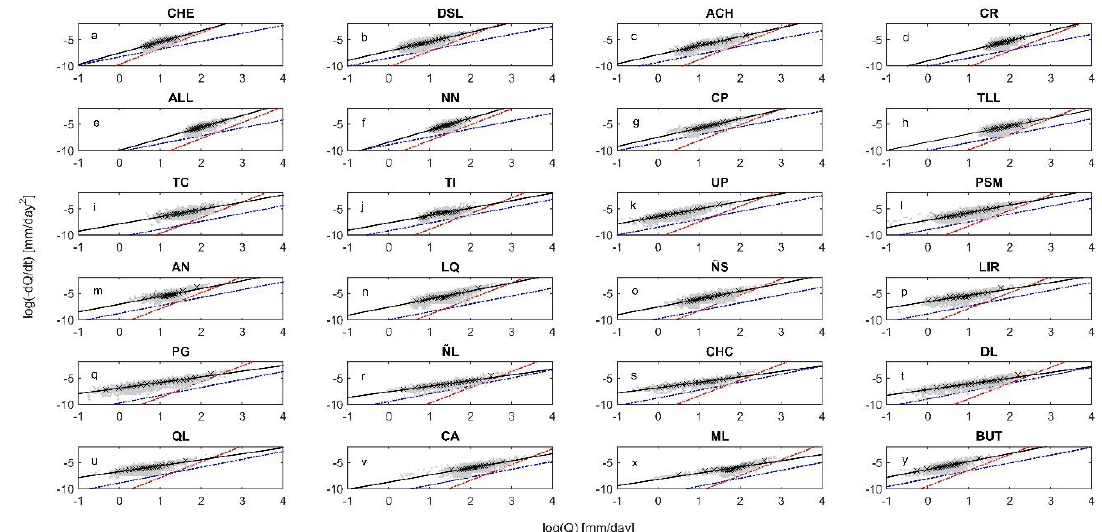
Figure 3. Recession flows for each studied watershed. Gray points indicate the recession flows. The dashed blue line establishes the lower envelope associated with an aquifer with long-term drainage (slope = 3 / 2) and the dashed red line an aquifer that drains in a short time (slope = 3), respectively. In addition, the linear regression of the data bins is shown. ( a – p ) are recession graphs of mountain watersheds, while ( q – v ) are recession graphs of Central Calley watersheds and ( x , y ) are recession graphs of coastal watersheds. The X marks represent the data bins. The black line is the linear regression applied to the data bins with the least-squares method.